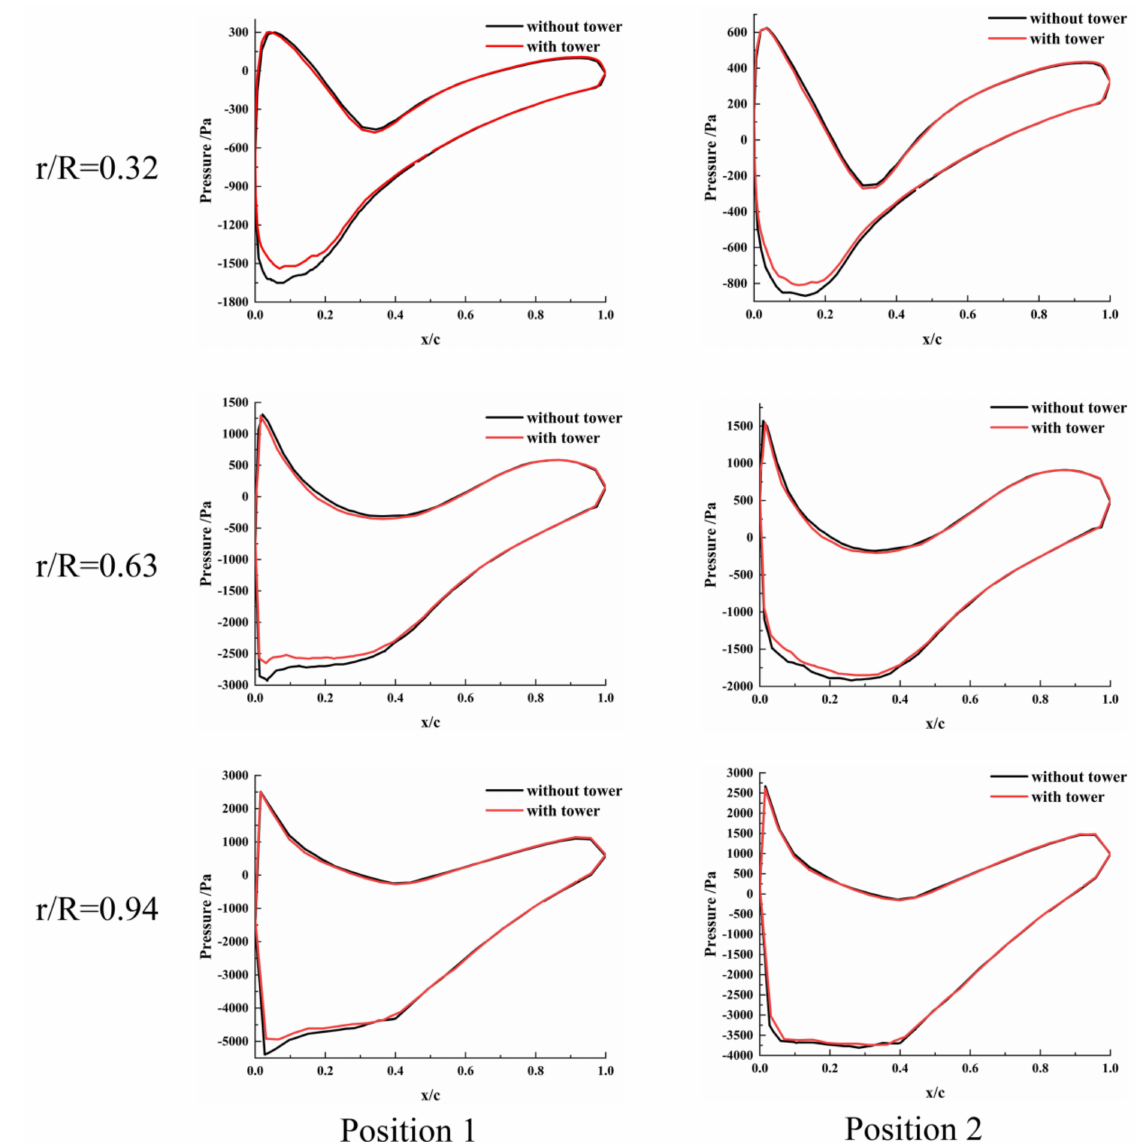
Figure 10. Distribution of pressure in each section of blade at position 1 and position